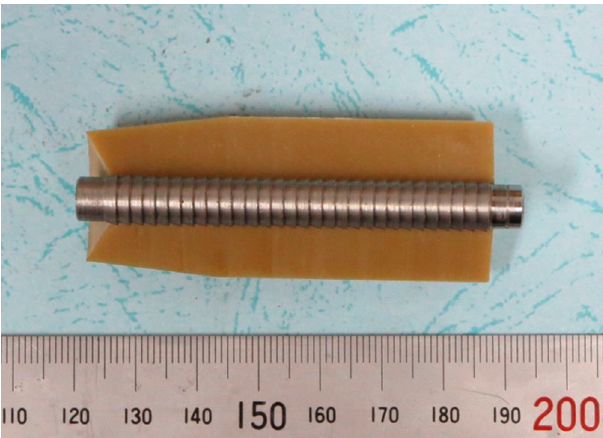
Figure 1. Long-rod projectile with sabot.